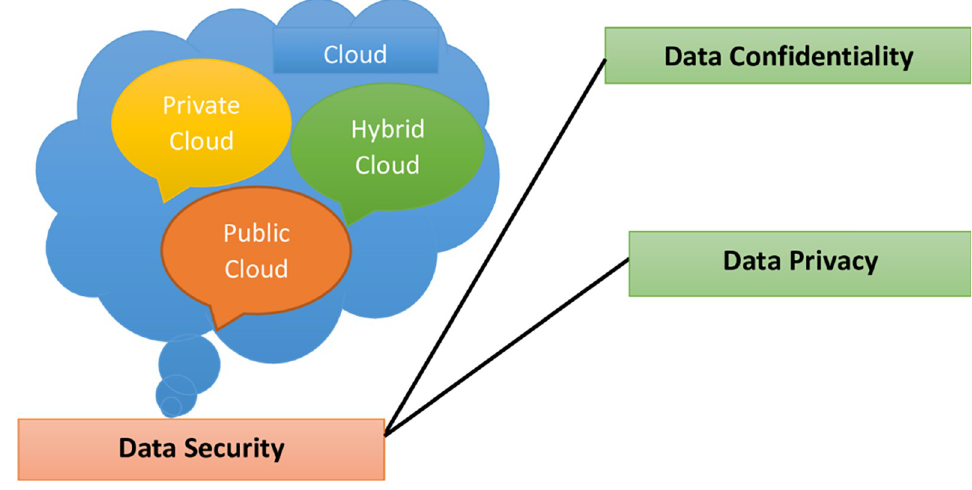
Fig 1. Data security elements in cloud computing